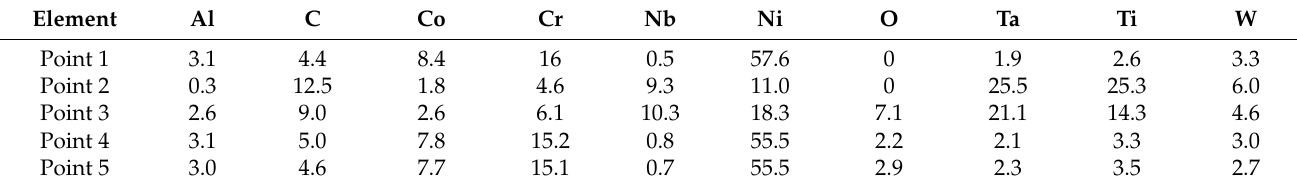
Figure 9. Backscatter electron image of a cracked region and selected points for EDS analysis. Table 4. EDS results in wt. % of the points illustrated in Figure 8.